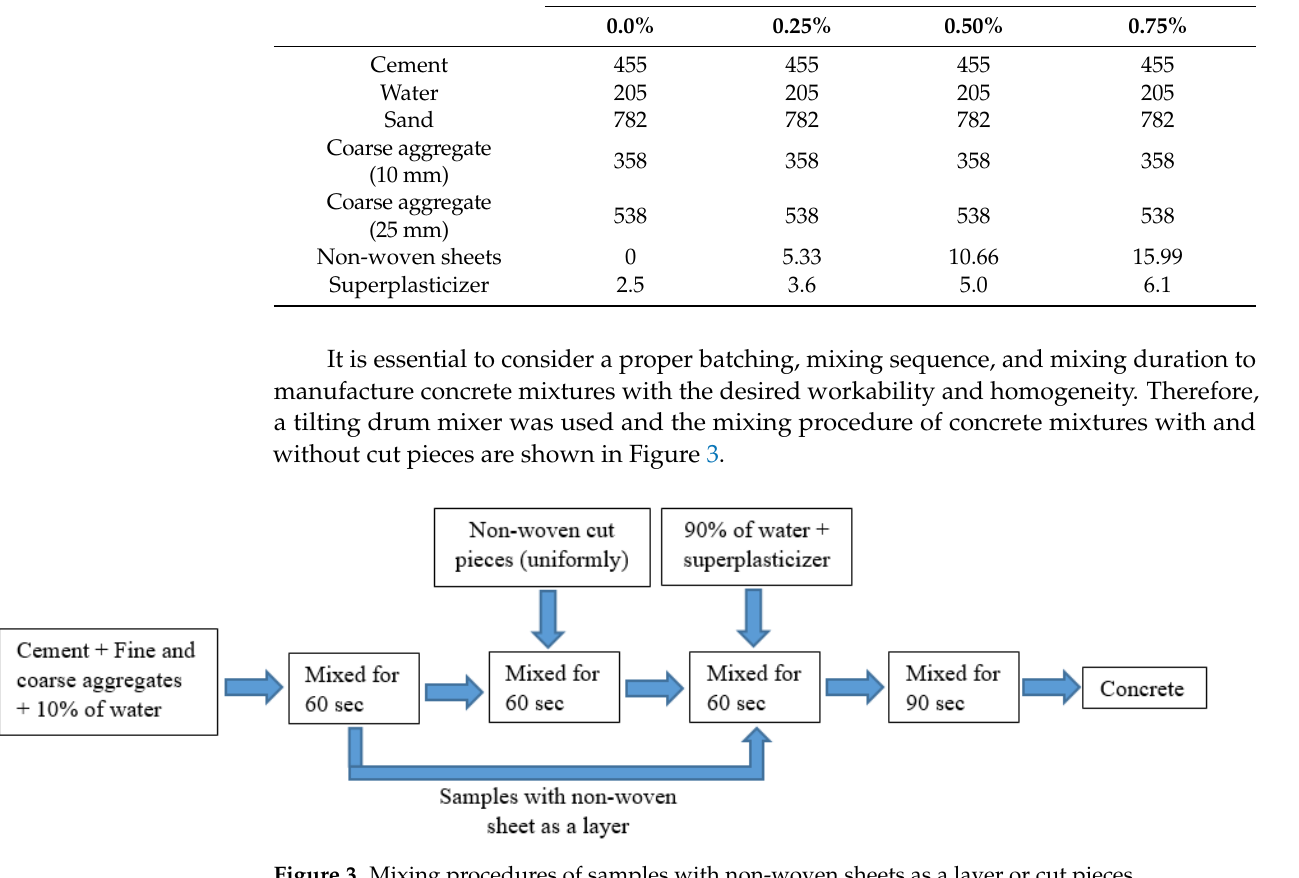
Figure 3. Mixing procedures of samples with non ‐ woven sheets as a layer or cut